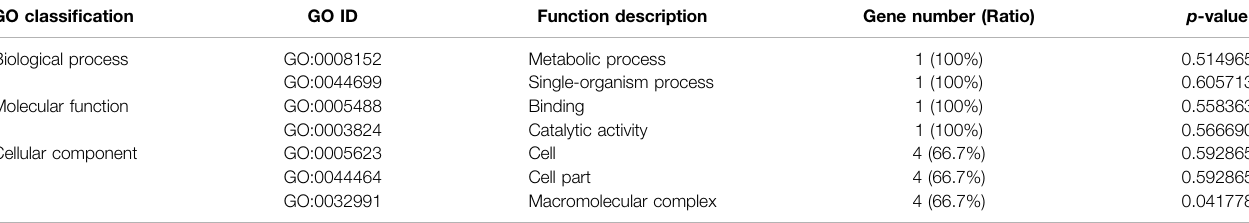
TABLE 7 | GO enrichment for strong positive select genes by comparing Zeugodacus cucurbitae (Coquillett) and Ceratitis capitata (Wiedemann). GO classi fi cation